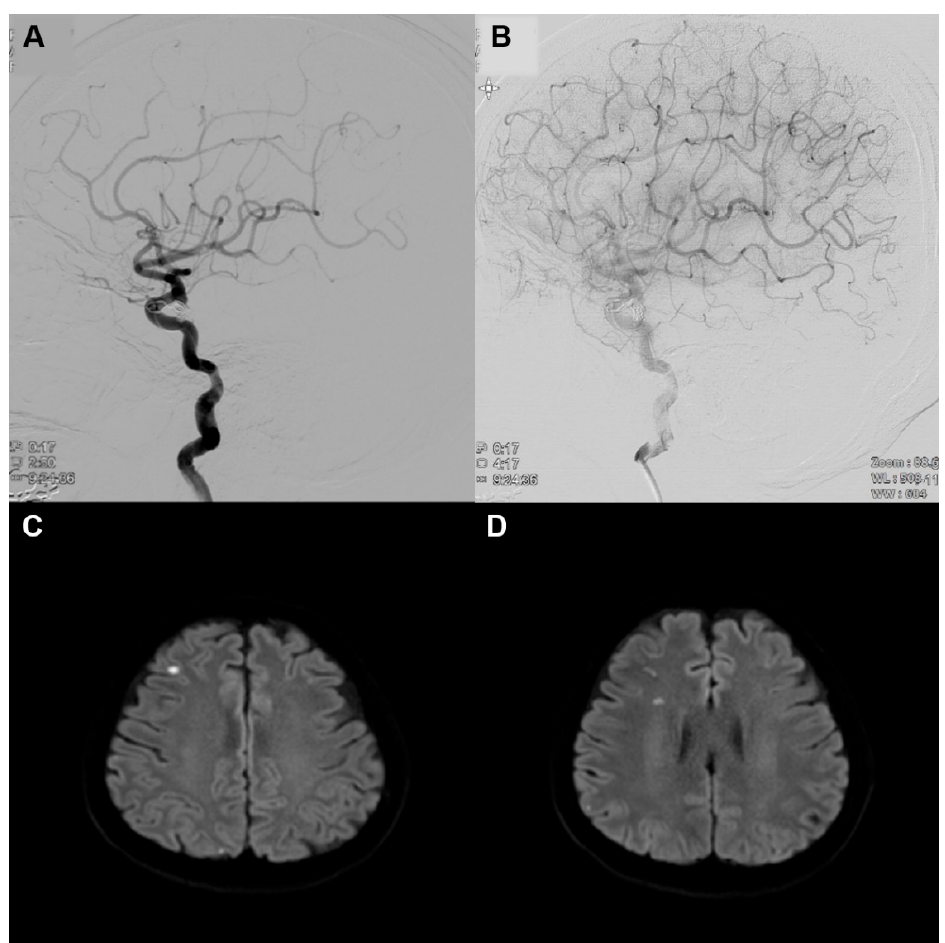
Figure 1. ( A ) Transfemoral cerebral angiography deconstrues the normal blood flow of the right ophthalmic artery. A previously clipped aneurysm is also noted on the right posterior communicating artery. ( B ) An intact choroidal blush is shown during the late arterial phase. ( C , D ) Diffusion-weighted MRI on the day following cerebral angiography revealed multiple focal scattered acute infarctions: right frontal, parietal, occipital, and temporal lobe. Fundus examinations revealed inferior sectoral optic disc swelling and small cotton wool spots (CWS) in the peripapillary area of the right eye. Fluorescein angiography (FA) showed early filling defects in the inferior segment of the optic nerve’s head and late leak- age from the optic disc. A Humphrey visual field 24-2 showed a superior altitudinal deficit that corresponds with inferior sectoral papilledema (Figure 2). We assumed the